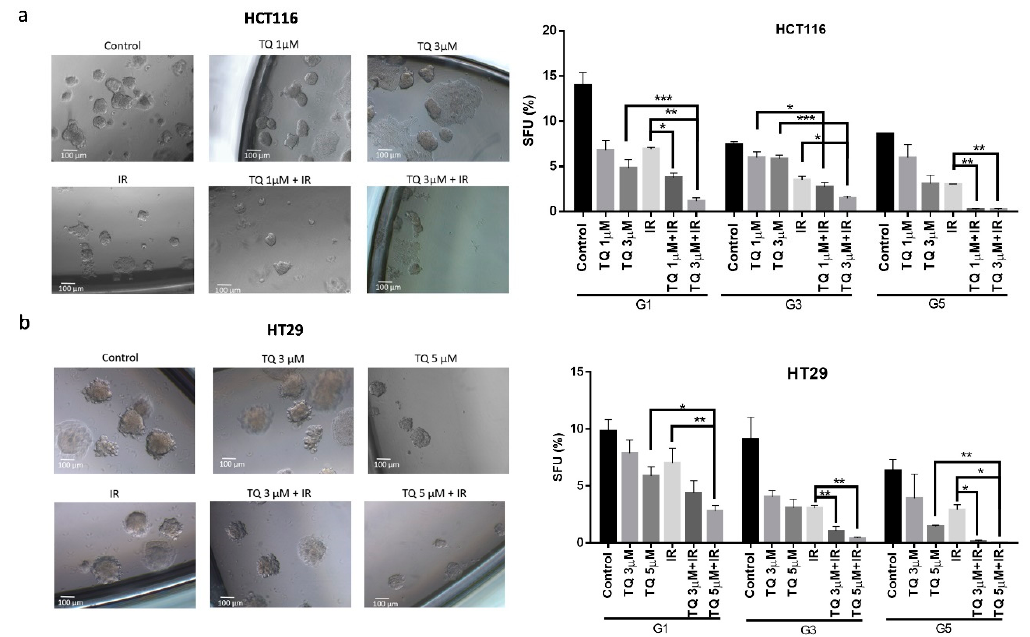
Figure 4. TQ radiosensitizes colorectal cancer stem/progenitor cells and reduces their sphere-forming and self-renewal ability. Sphere forming unit (SFU) obtained from serially passaged colonospheres over five generations is shown for HCT116 ( a ) and HT29 ( b ) spheres treated with TQ (1, 3 and 5 µM), radiation (2 Gy), or combinations. SFU is calculated according to the following formula: SFU = (number of spheres counted ÷ number of input cells) × 100. HCT116 and HT29 cells were suspended in Growth Factor reduced Matrigel/serum-free media (ratio 50:50) and allowed to grow in media with 5%FBS (with or without treatment) to enrich for colorectal CSCs. Generated spheres are referred to as G1 (Generation 1) spheres. After each propagation, cells that were initially treated with TQ, IR, TQ+IR, or media (control) were seeded into separate wells. Spheres were propagated for five generations in duplicates for each condition. Data represent an average of three independent experiments and are reported as mean ± SEM (* p < 0.05; ** p < 0.01; *** p < 0.001). Representative bright-field images showing the effect of TQ, IR, and combinations on SFU of HCT116 and HT29 spheres are shown next to the respective graphs. Images were visualized by Axiovert inverted microscope at 10 × magnification and analyzed by Carl Zeiss Zen 2012 image software. Scale bar 100 µ